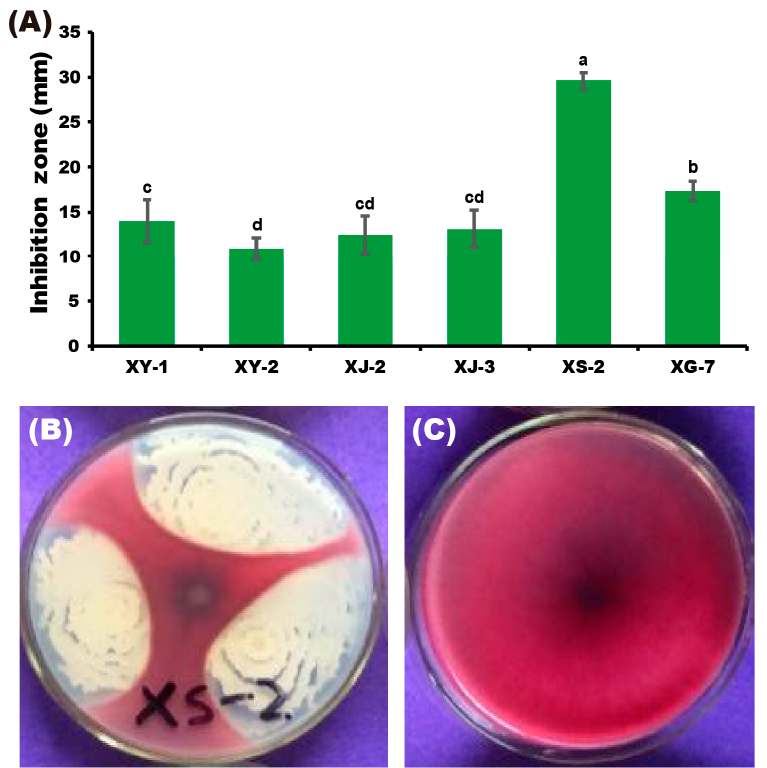
Figure 1. Antagonistic effects of endophytic bacteria on Fusarium graminearum . ( A ) Inhibition effects of six endophyte isolates against F . graminearum . ( B ) The antagonistic effect of XS-2 against F . graminearum and ( C ) F . graminearum growth alone. Values are means ± SD ( n = 10). Different letters above the bars indicate a significant difference at p < 0.05.